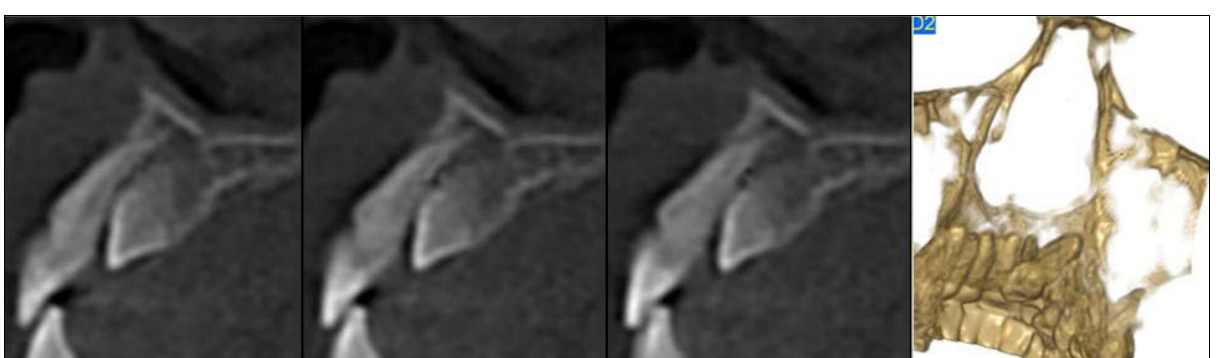
Figure 2. Panoramic radiograph of a 46-year-old patient showing a horizontal canine transmigration in the maxilla.